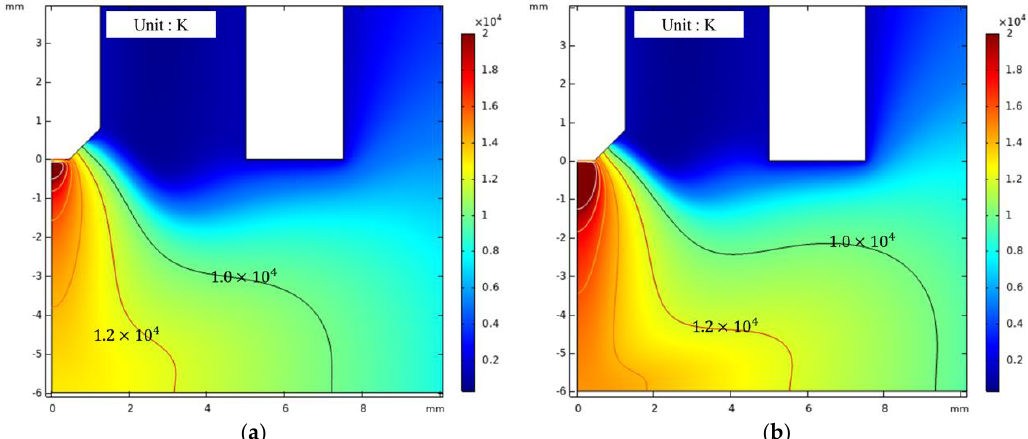
Figure 5. Temperature distribution of arc plasma for the current of ( a ) 100 A; ( b ) 150 A.